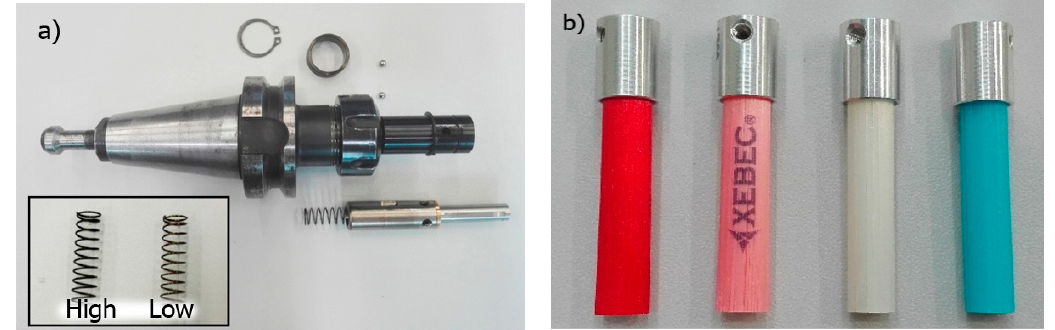
Figure 3. Ceramic brushes: ( a ) brush adjustment sleeve; ( b ) fibre types.